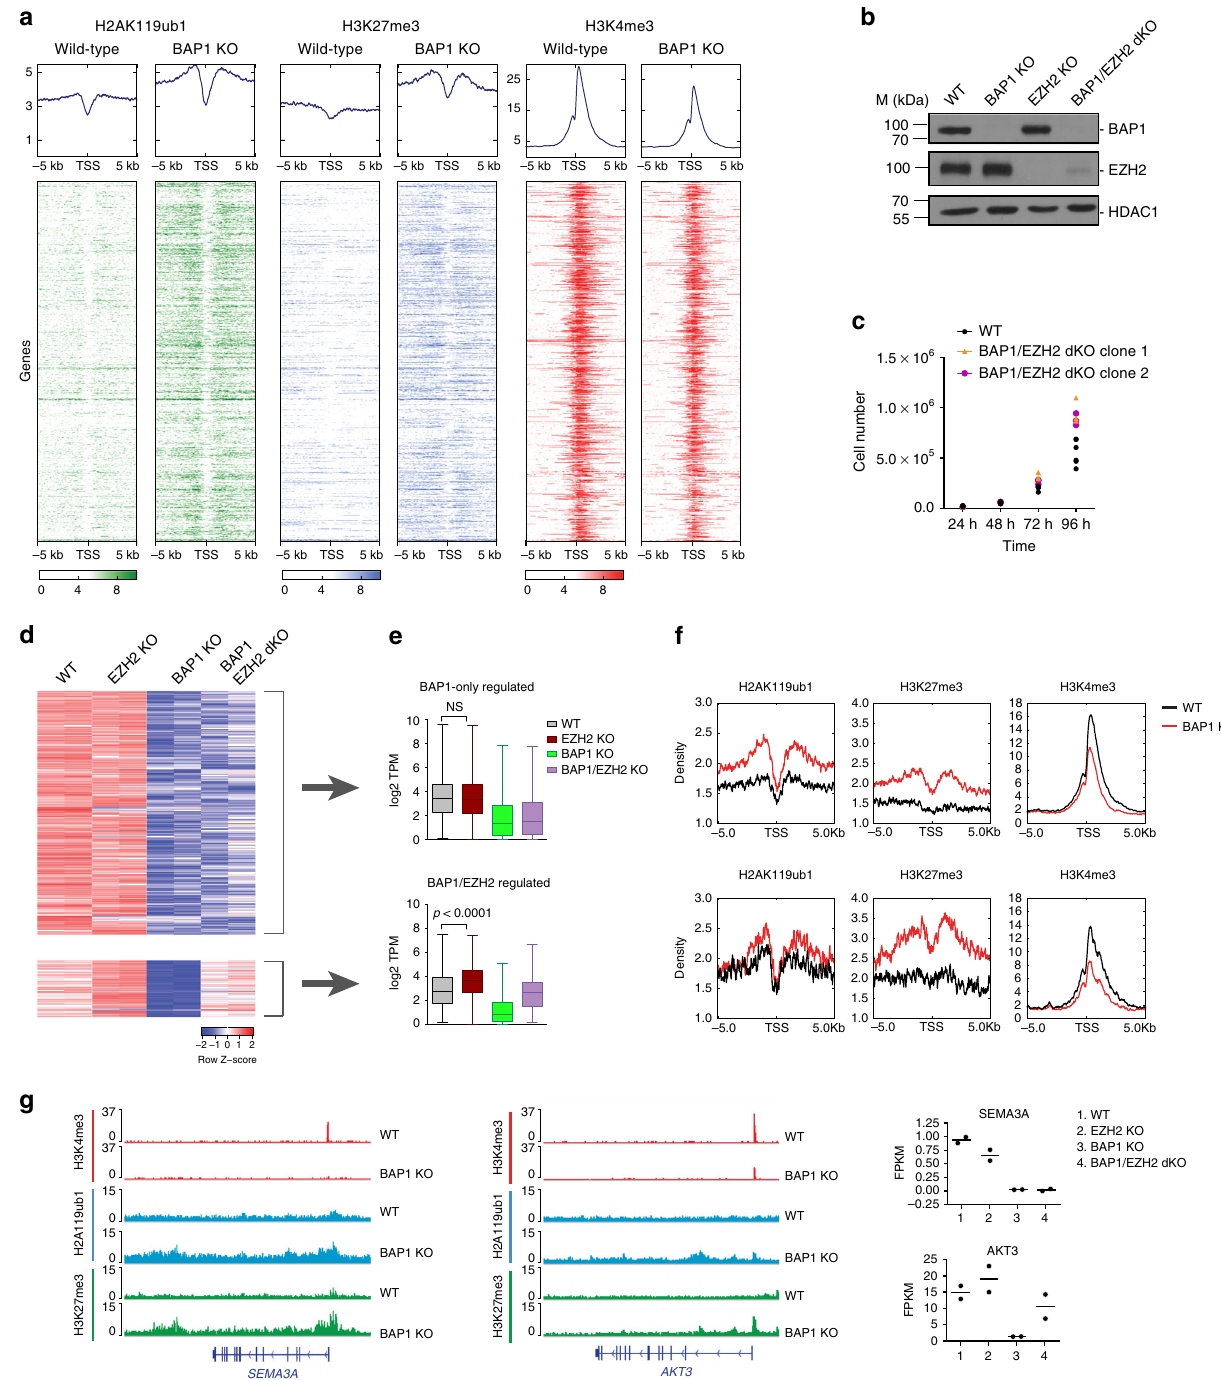
Fig. 4 BAP1.com promotes transcription independently of an antagonism with the PRC2 complex. a Heatmaps showing H2AK119ub1, H3K27me3, and H3K4me3 distribution in a − 5/ + 5 kb window around the transcription start site (TSS) of genes downregulated in BAP1 KO cells in wild-type and BAP1 KO cells. Corresponding average pro fi les are plotted on top of each heatmap. b Western blot analysis of BAP1 and EZH2 in single and double BAP1/EZH2 KO cells. HDAC1 is used as a loading control. c Dot plot showing proliferation of wild-type cells and two independent clones of BAP1/EZH2 dKO cells. n = 3. d Heatmap of gene expression ( Z -scores) in the different genotypes. Top: BAP1-only-regulated genes, and bottom: BAP1- and EZH2-regulated genes, TSS = transcription start site. e Box-plots (median, lower, and upper quartiles, lowest and highest values) of log2 transcript per million (TPM) expression values of BAP1-only-regulated genes (top) and BAP1/EZH2-regulated genes 61 in the different conditions as indicated. Result of the Mann – Whitney test on the EZH2 KO versus wild-type comparison is indicated. f Plot showing average enrichment of H2AK119ub1, H3K27me3, and H3K4me3 in a − 5/ + 5 kb around the TSS for BAP1-only-regulated genes (top) and BAP1/EZH2-regulated genes 61 . g Example snapshots of H2AK119ub1, H3K27me3, and H3K4me3 enrichment in WT and BAP1 KO cells at a BAP1-only-regulated gene and a BAP1/EZH2-regulated gene (middle). Expression values of the corresponding genes across WT, EZH2 , BAP1 , and BAP1/EZH2 KO conditions as detected in corresponding RNA-seq data are shown on the right. Horizontal bars indicate the mean